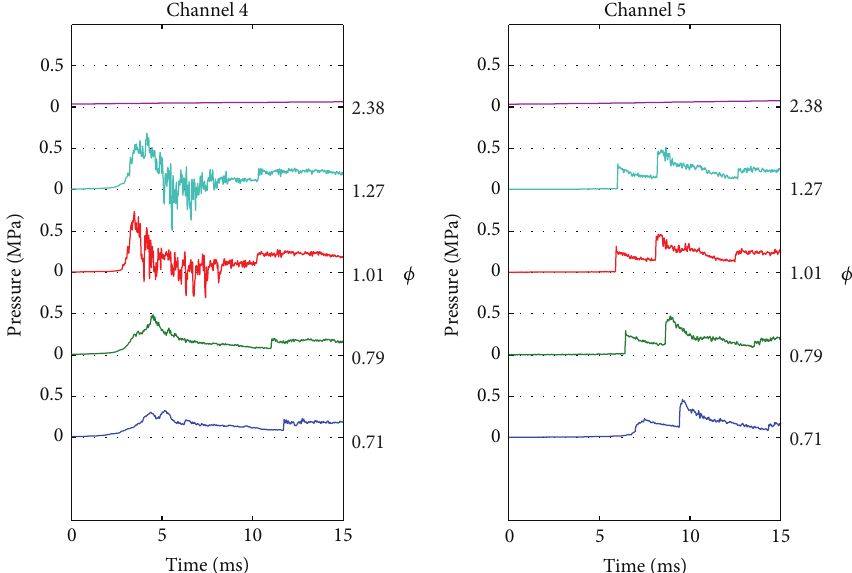
Figure 10: From bottom: tests 29, 27, 28, 30, and 49. Comparison of pressure records from channels 4 and 5 for lean, stoichiometric, and rich H 2 S-air mixtures. Pressure is shown on left vertical axis, while the equivalence ratio is given on the right vertical axis.